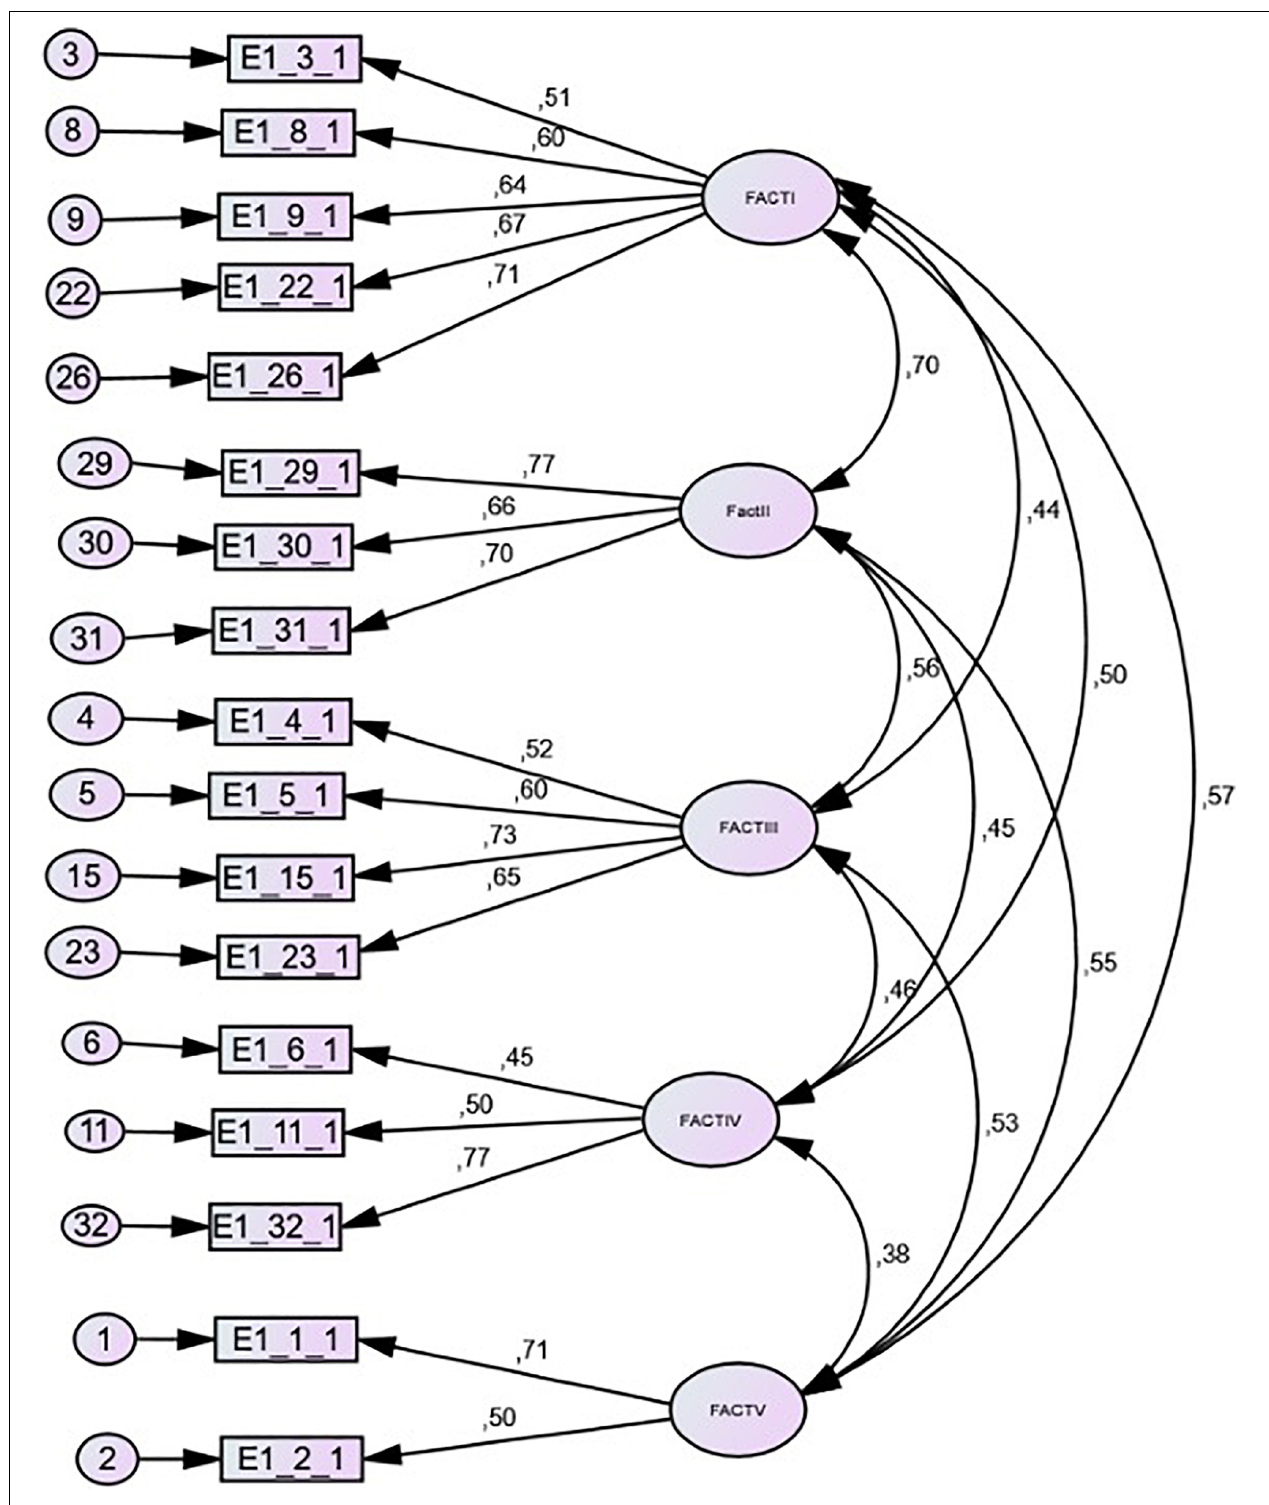
FIGURE 1 | CFA model for the Generic competencies